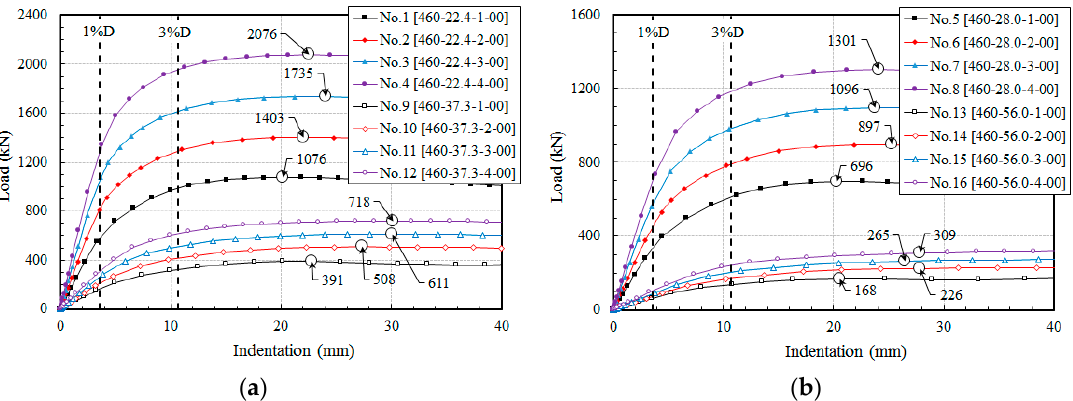
Figure 9. Load–indentation curves of HSB600 ( F y = 460 MPa): ( a ) 2 γ of 22.4 and 37.3; ( b ) 2 γ of 28.0 and 56.0.